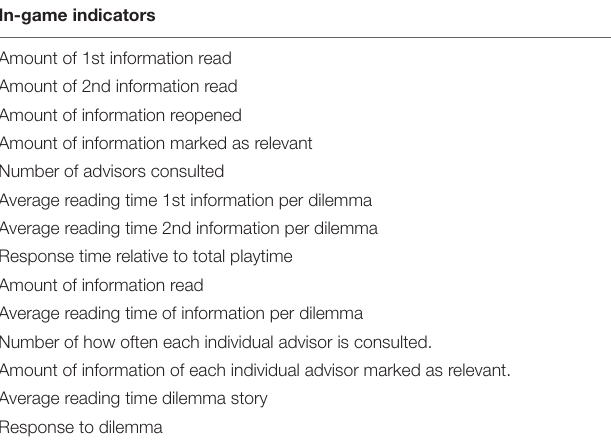
TABLE 1 | In-game indicators available for the operationalization. In-game indicators Amount of 1st information read Amount of 2nd information read Amount of information reopened Amount of information marked as relevant Number of advisors